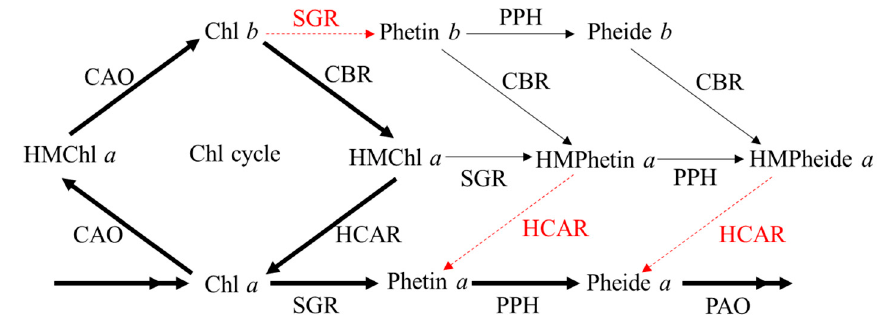
Figure 1. Chlorophyll cycle and degradation pathway in land plants. Thick arrows represent the major Chl metabolic pathways. Thin arrows represent the possible minor Chl metabolic pathways. Dotted arrows and the names of the enzymes beside them are in red, which indicate that the labelled enzymes have no activity to catalyze the corresponding steps in vitro. Phetin: pheophytin.